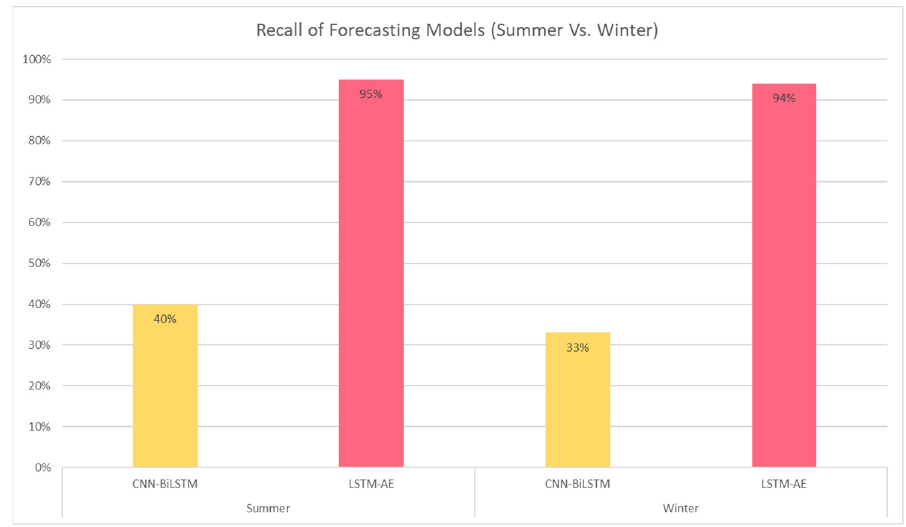
Figure 37. Recall of the two forecasting models (summer vs. winter) in model prediction engine.